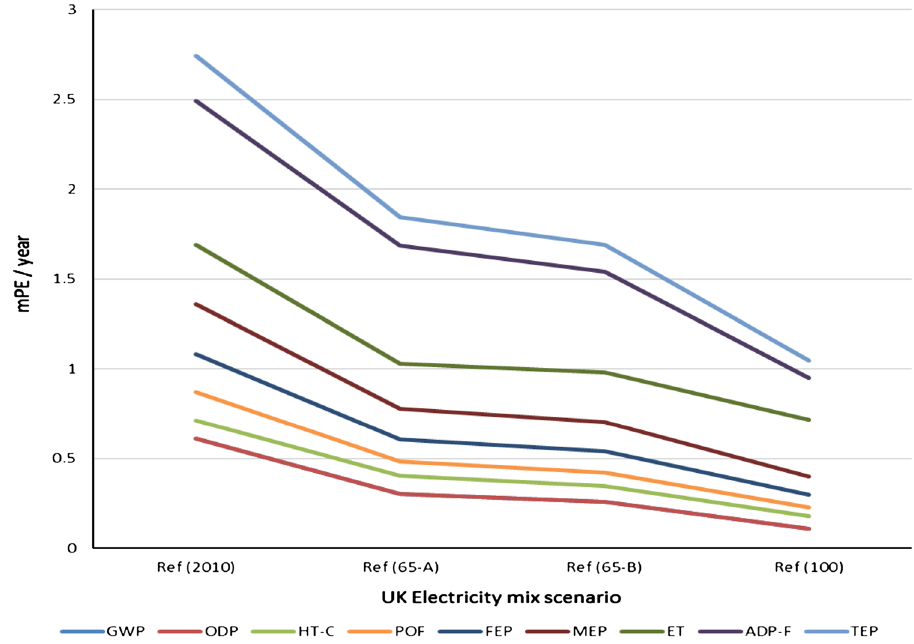
Fig. 6 Normalised environmen- tal burdens of different energy scenarios: 2010 UK electricity mix (Ref 2010), 65% of renewa- bles without nuclear energy (Ref 65-A), and with nuclear energy (Ref 65-B), and 100% of renewable energy with nuclear energy (Ref 100). Abbreviations are listed under Fig.